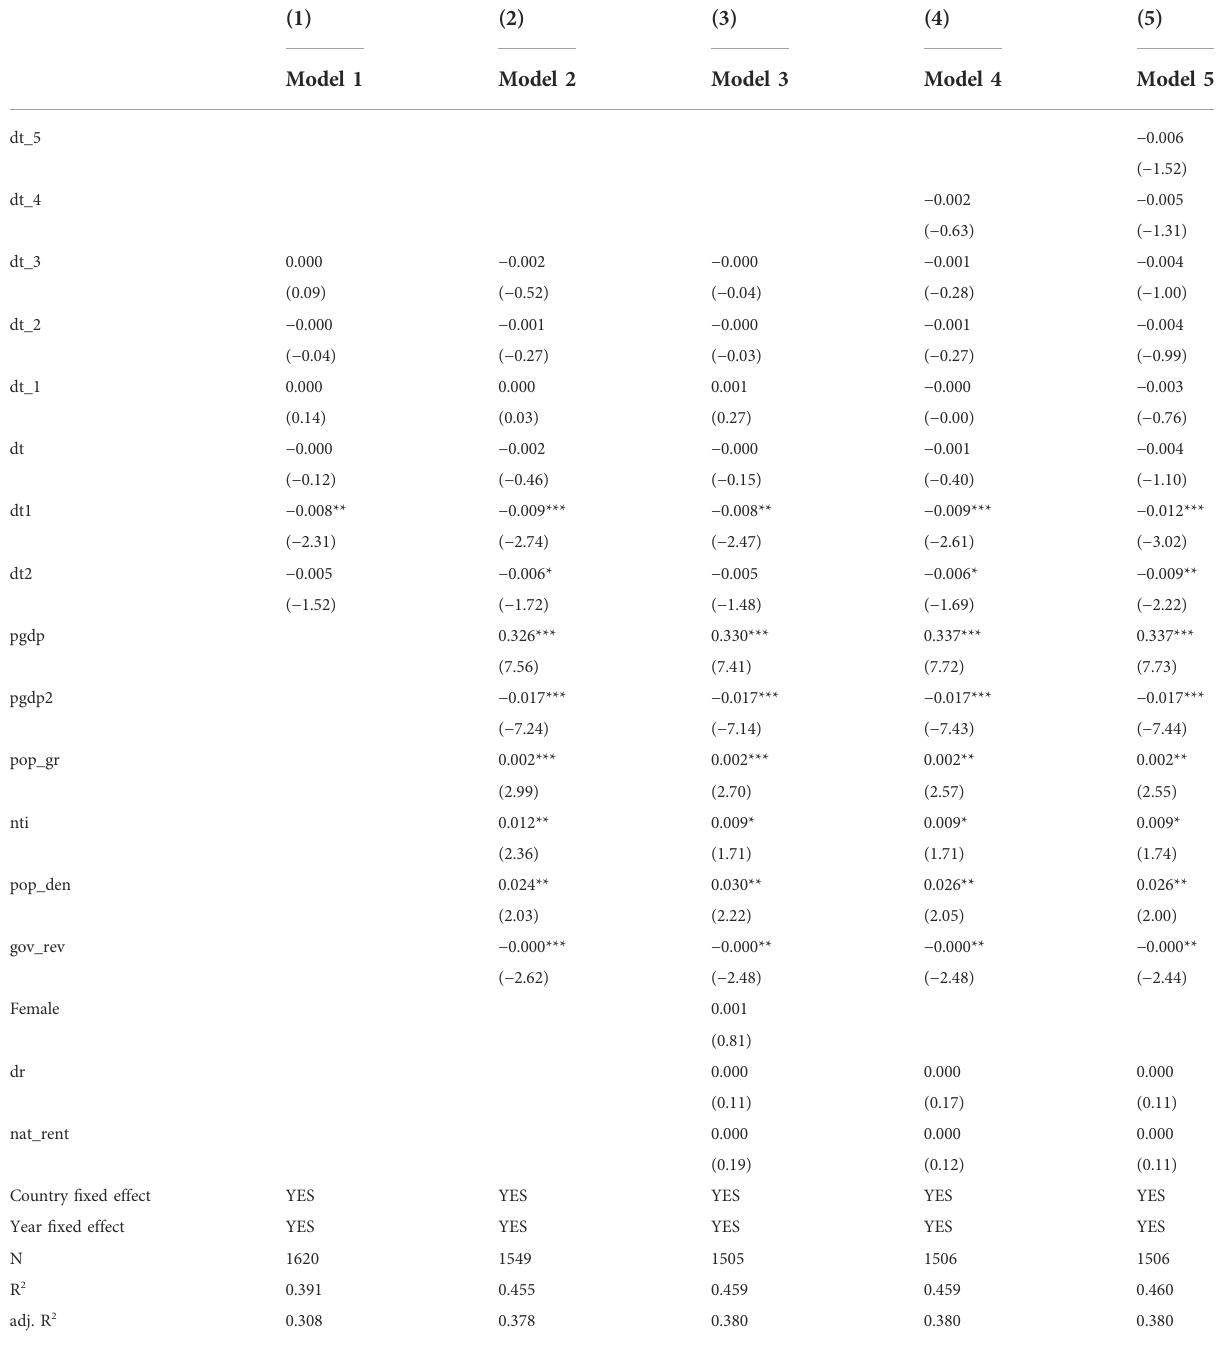
TABLE 3 Effects of the Belt and Road Initiative on environmental quality: Parallel trend